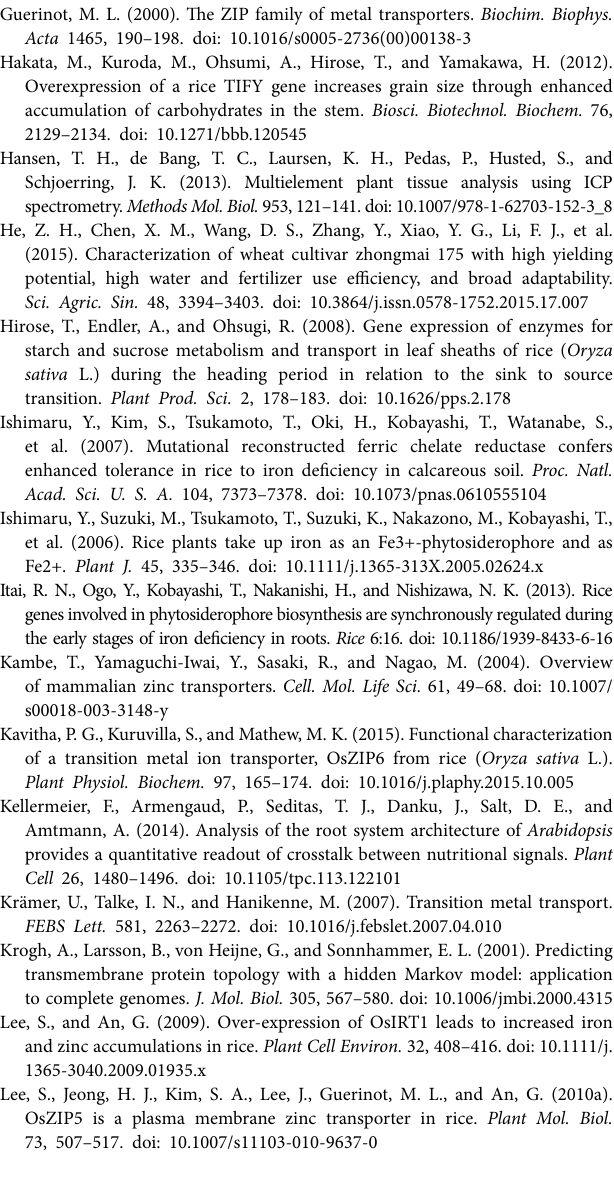
Supplementary Figure S2 | Chromosome locations of these 58 TaZIP genes.